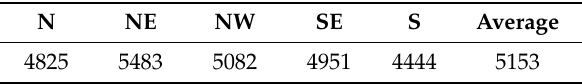
Table 5. Monthly average of daily totals (Wh/m 2 ) of horizontal global irradiation observed in Brazil. N, E, S, and W—north, east, south, and